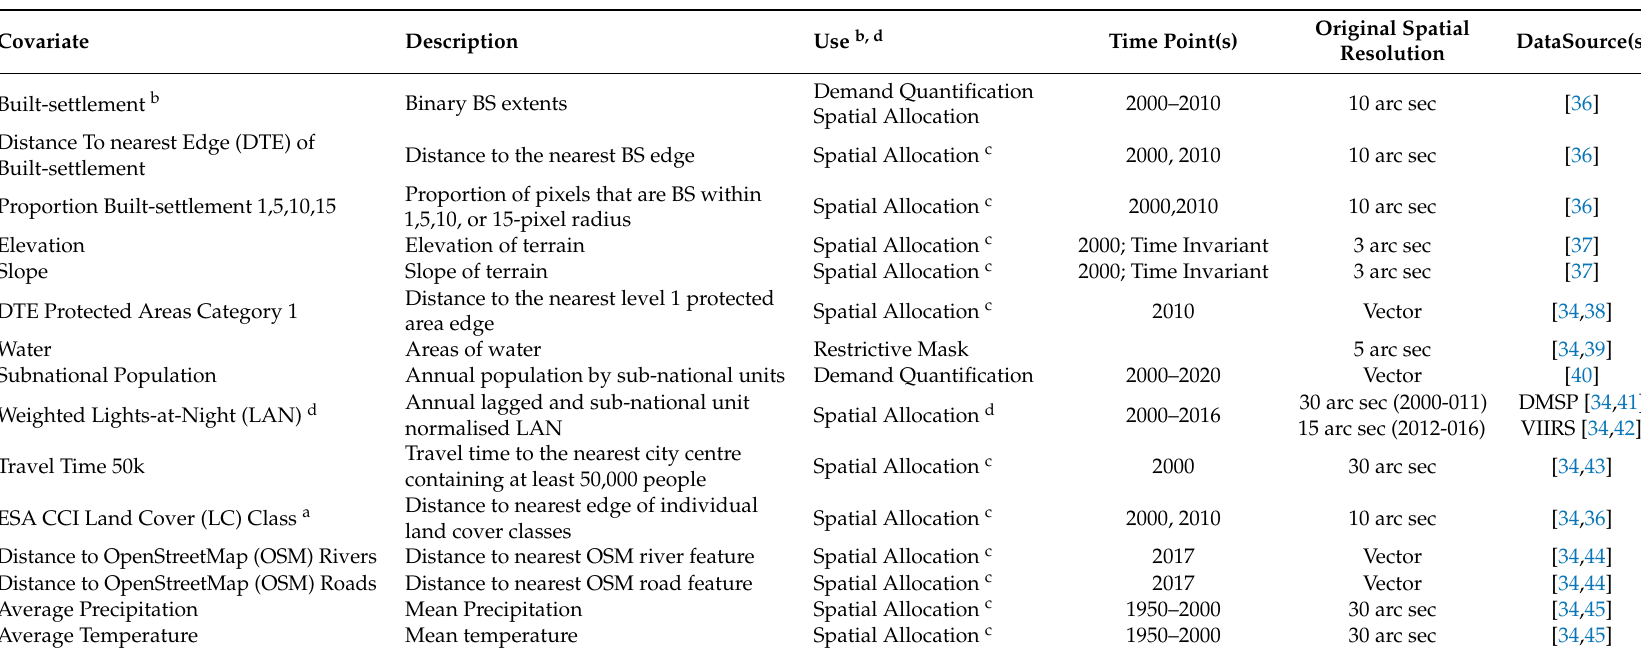
Table 2. Data used for estimating the annual number of non- Built-Settlement (BS) to BS transitions at the unit level (i.e. demand quantification), predicting the pixel level probability surface of those transitions, and performing the spatial allocation procedures of the model. Adapted from Nieves et al.